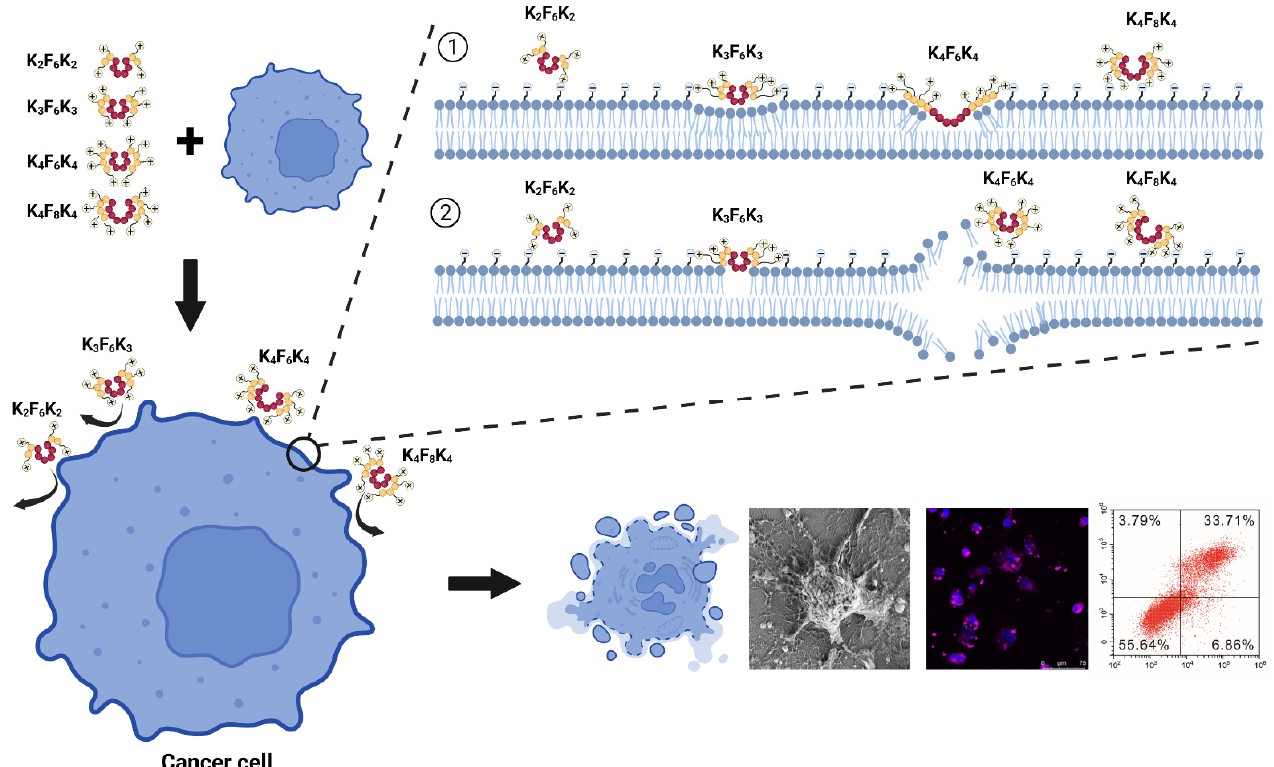
Figure 8. Schematic diagram of membrane disruption induced by K n F m K n analogues (K ₂ F ₆ K ₂ , K 3 F 6 K 3 , K 4 F 6 K 4 , and K 4 F 8 K 4 ) against lung cancer cells A549. 1 (cid:13) Firstly, the cationic K n F m K